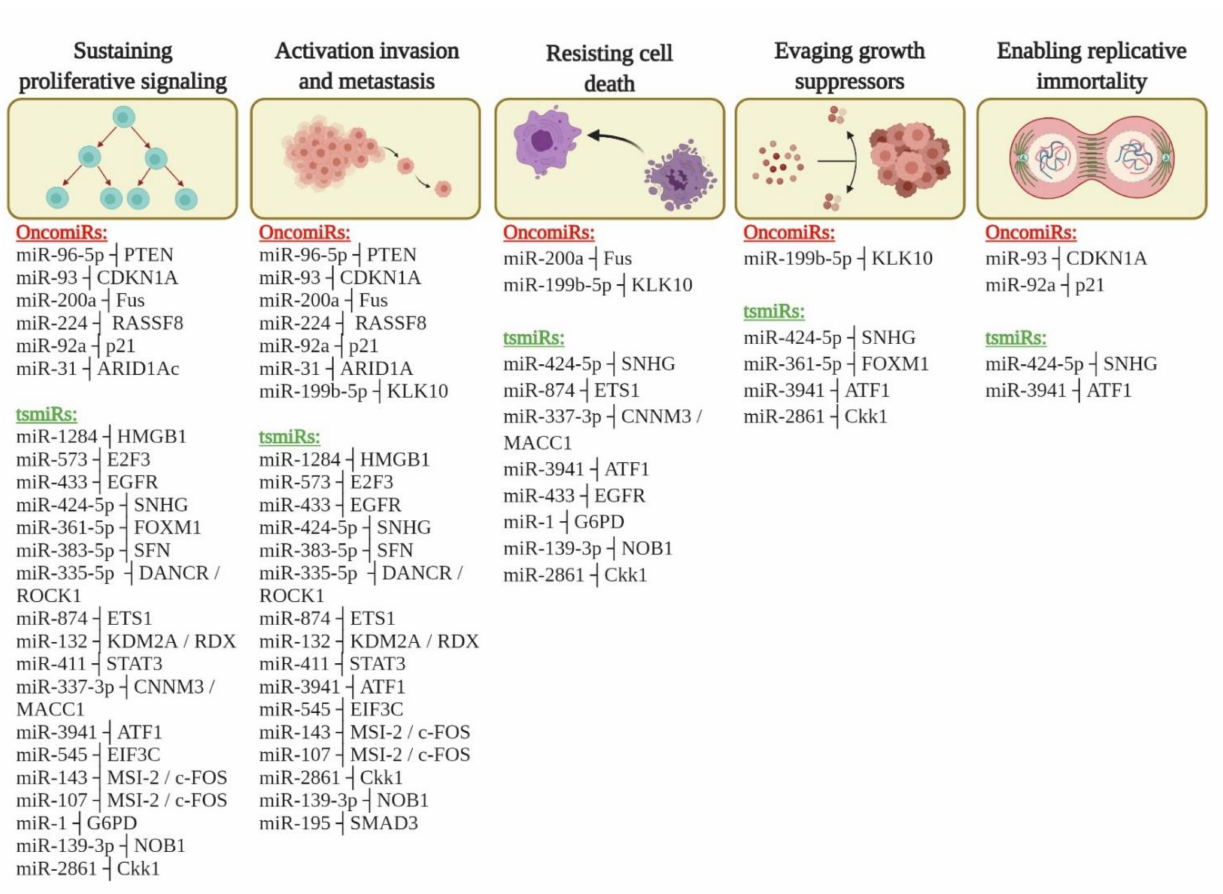
Figure 5. miRNAs involved in post-transcriptional regulatory interactions in cervical cancer. The oncogenic miRNAs (oncomiRs) and tumor suppressor miRNAs (tsmiRs) associated with various hallmark characteristics of cervical cancer are listed under the red and green subheadings, respectively. Each of these miRNAs can post-transcriptionally regulate a large number of genes involved in cervical cancer. The symbol ┤ indicates a negative regulating miRNA and target gene. Table 4. miRNAs involved in cervical cancer’s clinical outcome.